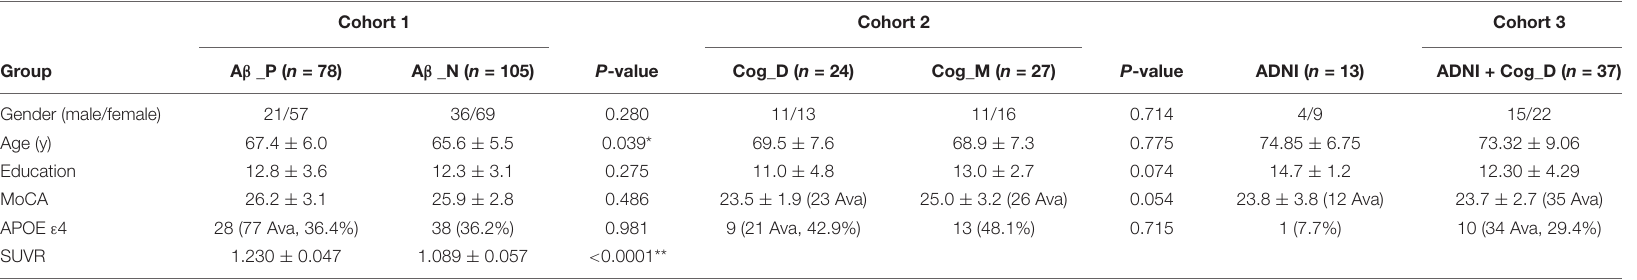
TABLE 1 | Clinical characteristics of participants. Cohort 1 Cohort 2 Cohort